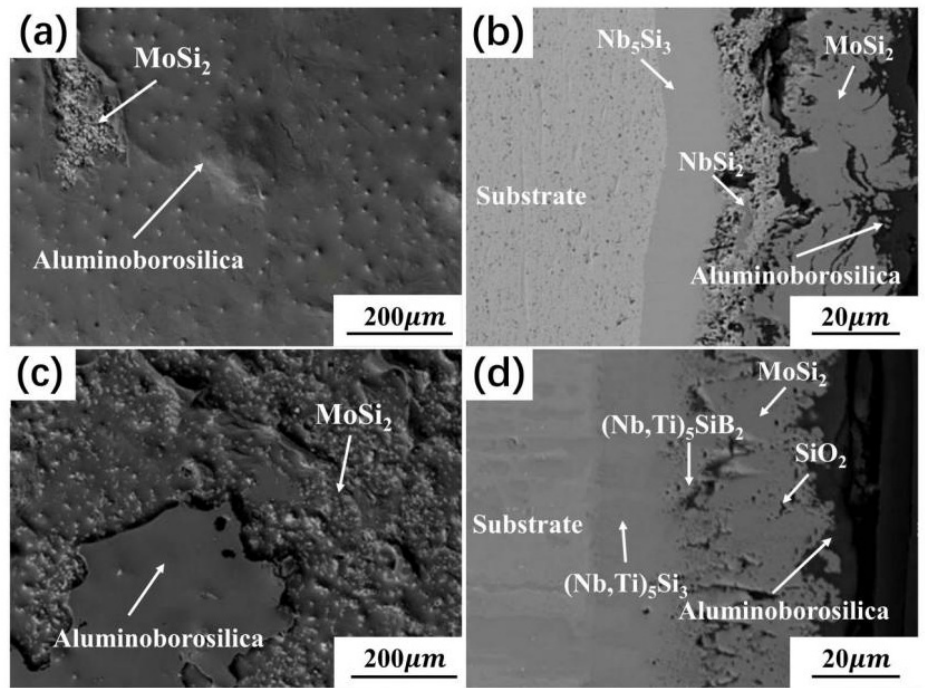
Figure 11. SEM of oxidized coatings prepared by the two-step method, ( a , b ) Mo-Si-B coating after oxidation at 1250 °C for 100 h; ( c , d ) Mo-Si-B coating after oxidation at 1300 °C for 24 h.